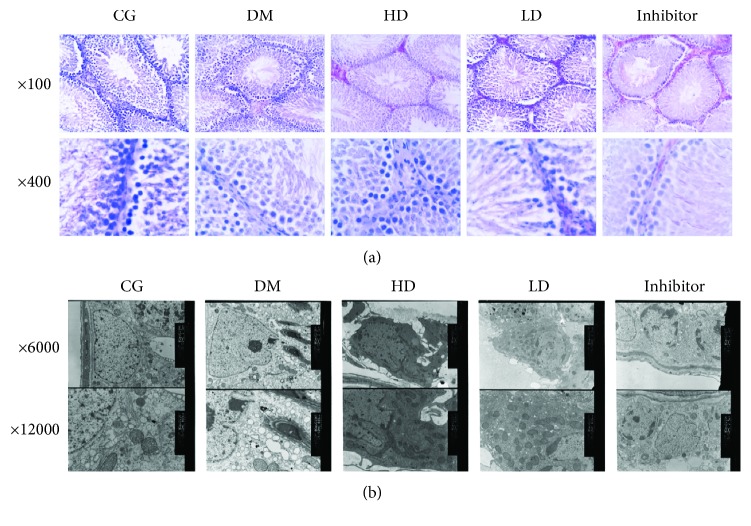
(a) Histopathological changes in testicular tissue under a light microscope (stained with hematoxylin and eosin dye, ×100, ×400). (b) Histopathological changes in testicular tissue under a transmission electron microscope (×6000, ×12000). Histological assessment under a light microscope showed that testicular tissues from the DM group exhibited extensive, loose interstitial cells and visible interstitial atrophy. The testicular tissue sections of the HD and LD groups exhibited slightly more active, spermatogenic cells that were arranged more closely, and a more significant number of interstitial cells. The histological properties of the CG group were superior to those of the above three groups. Based on transmission electron microscopy, the organelles of the testis tissue exhibited atrophy; the mitochondria, endoplasmic reticulum, and other organelles exhibited vacuoles; and the mitochondrial ridge was widened and dissolved. These changes were not observed in the interstitial cells in the CG group. The histological properties in the HD and LD groups showed altered expressions levels between the CG and DM groups. The level measured in the inhibitor group was slightly lower than that in the HD group.